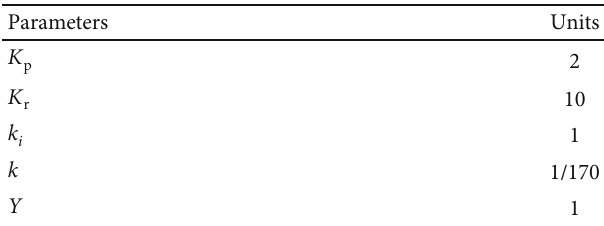
Table 1: Controller